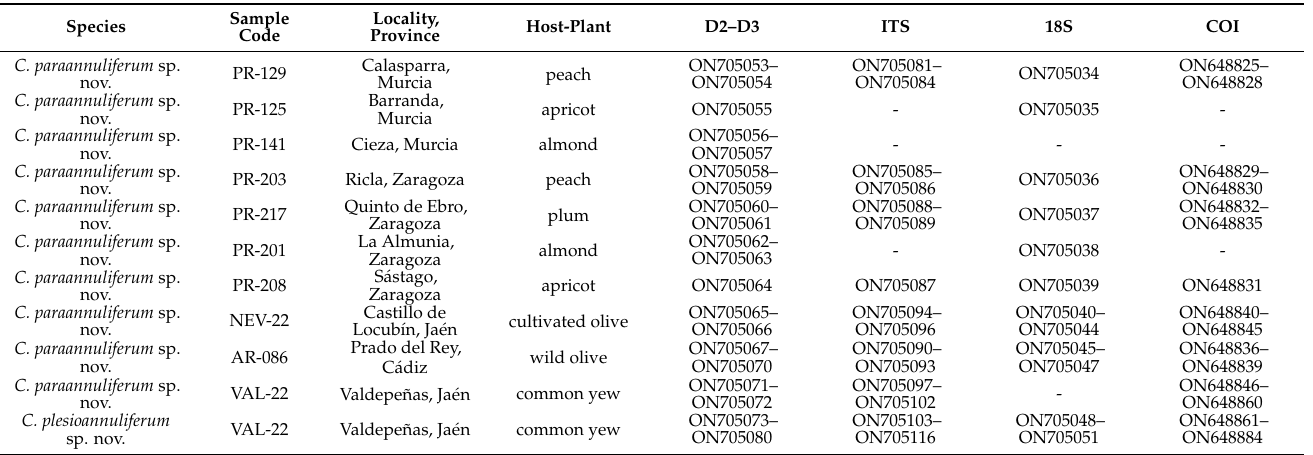
Table 1. Taxa sampled from the Criconema annuliferum -complex in this study from Spain and DNA sequence Genebank accession numbers